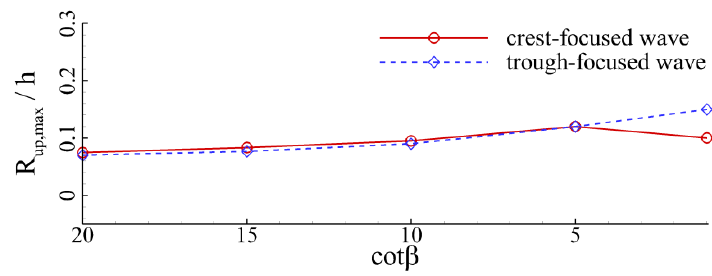
Figure 54. Maximum wave runup height versus the backreef slope.